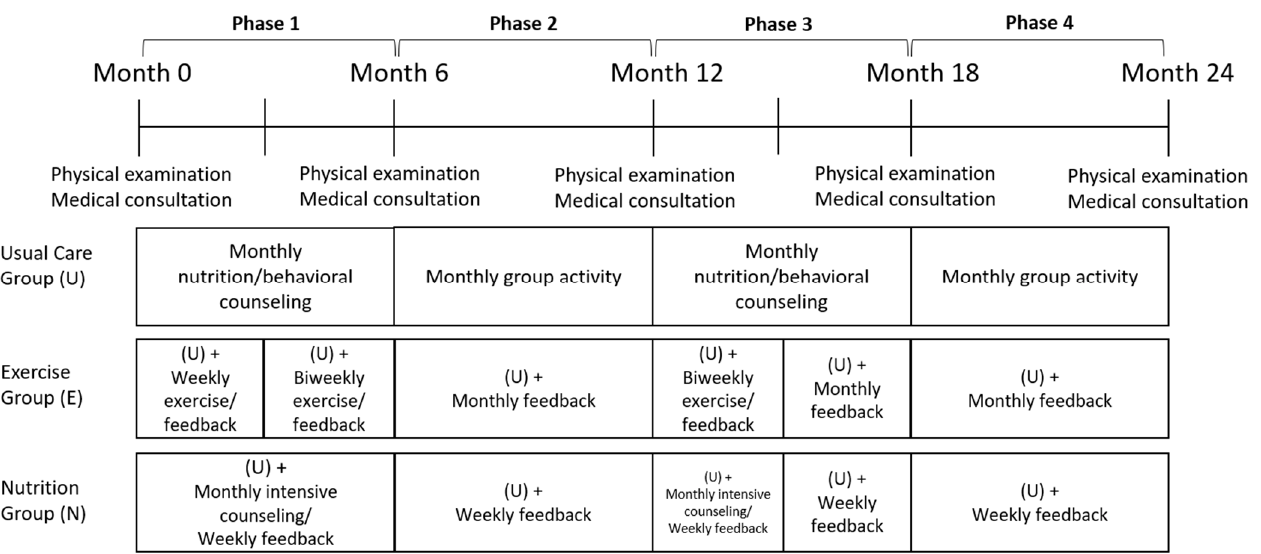
Figure 2. Flowchart of the